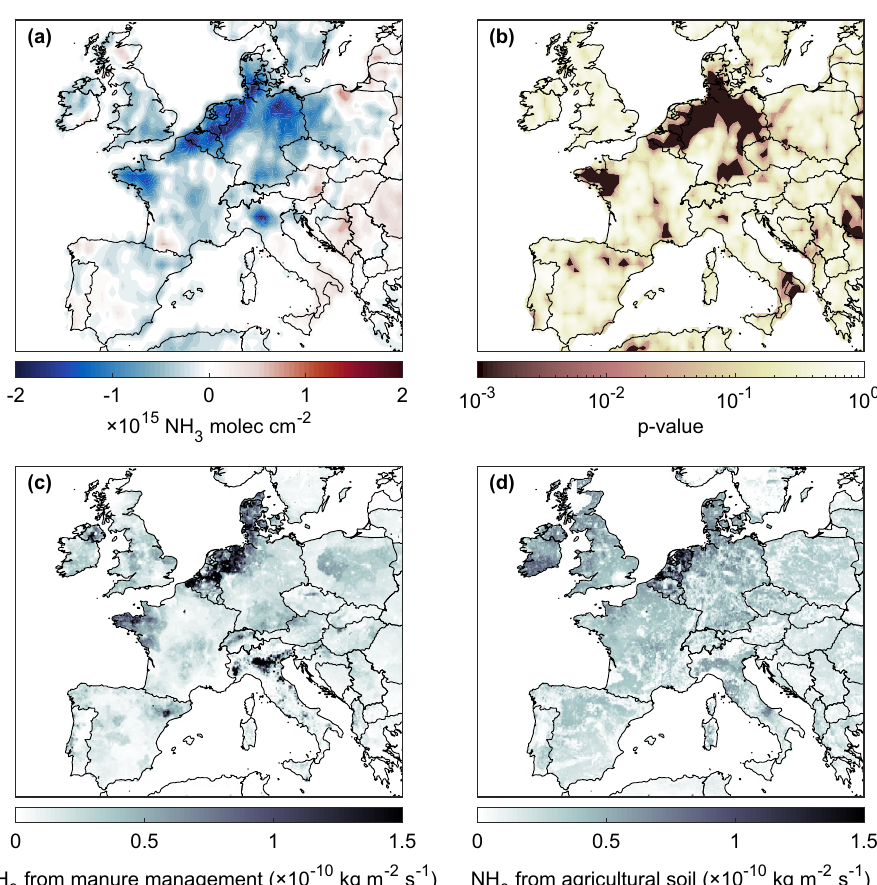
− 2 Figure 2. ( a ) Distribution over Europe of the difference in NH 3 columns (molec cm ) between the average of the Sunday–Monday IASI morning observations (2008–2020) and the average for the rest of the week (weekend effect). ( b ) Distribution of the associated p -value calculated with the Mann-Whitney test to assess whether the ◦ × ◦ − 2 − 1 magnitude of the weekend effect observed is significant (0.5 0.5 grid). ( c – d ) NH 3 emissions (kg m s ) from manure management and agricultural soil in 2015 from the Emissions Database for Global Atmospheric ◦ × ◦ Research (EDGAR) 39 (0.1 0.1